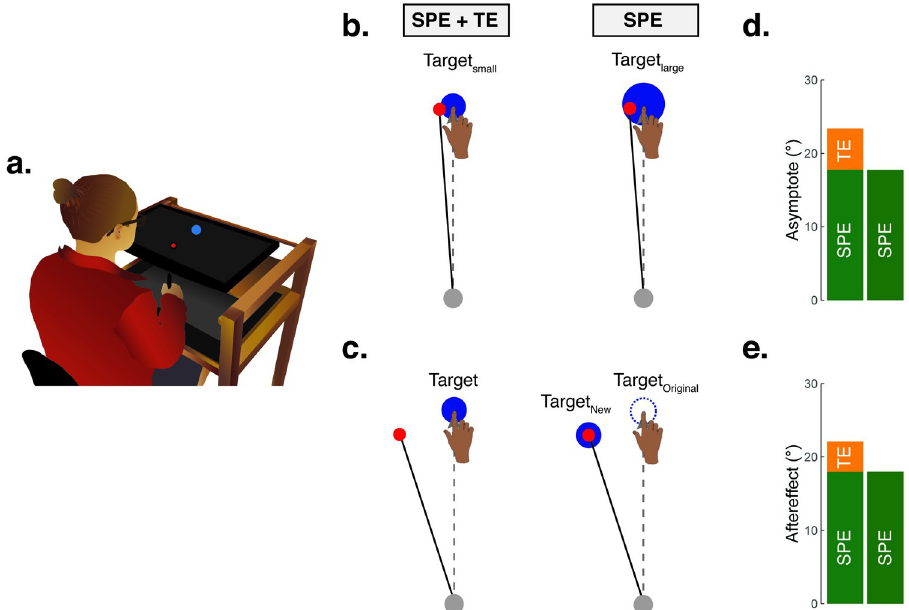
Fig 1. Implicit recalibration elicited by SPE + TE and SPE-only. (a) Illustration of experimental apparatus. (b-c) Task outcome was manipulated by either varying the size of the target (Kim et al, 2019) or varying the size of the target jump (Leow et al, 2018). Both SPE and TE are present when the cursor feedback straddles or misses the target, and only SPE is present when the cursor “hits” the target. (d-e) Implicit recalibration, as measured by the asymptote of hand angle in a clamped feedback design in Kim et al 2019 or during no-feedback aftereffect trials in a standard visuomotor rotation design, was reduced when TE was removed.